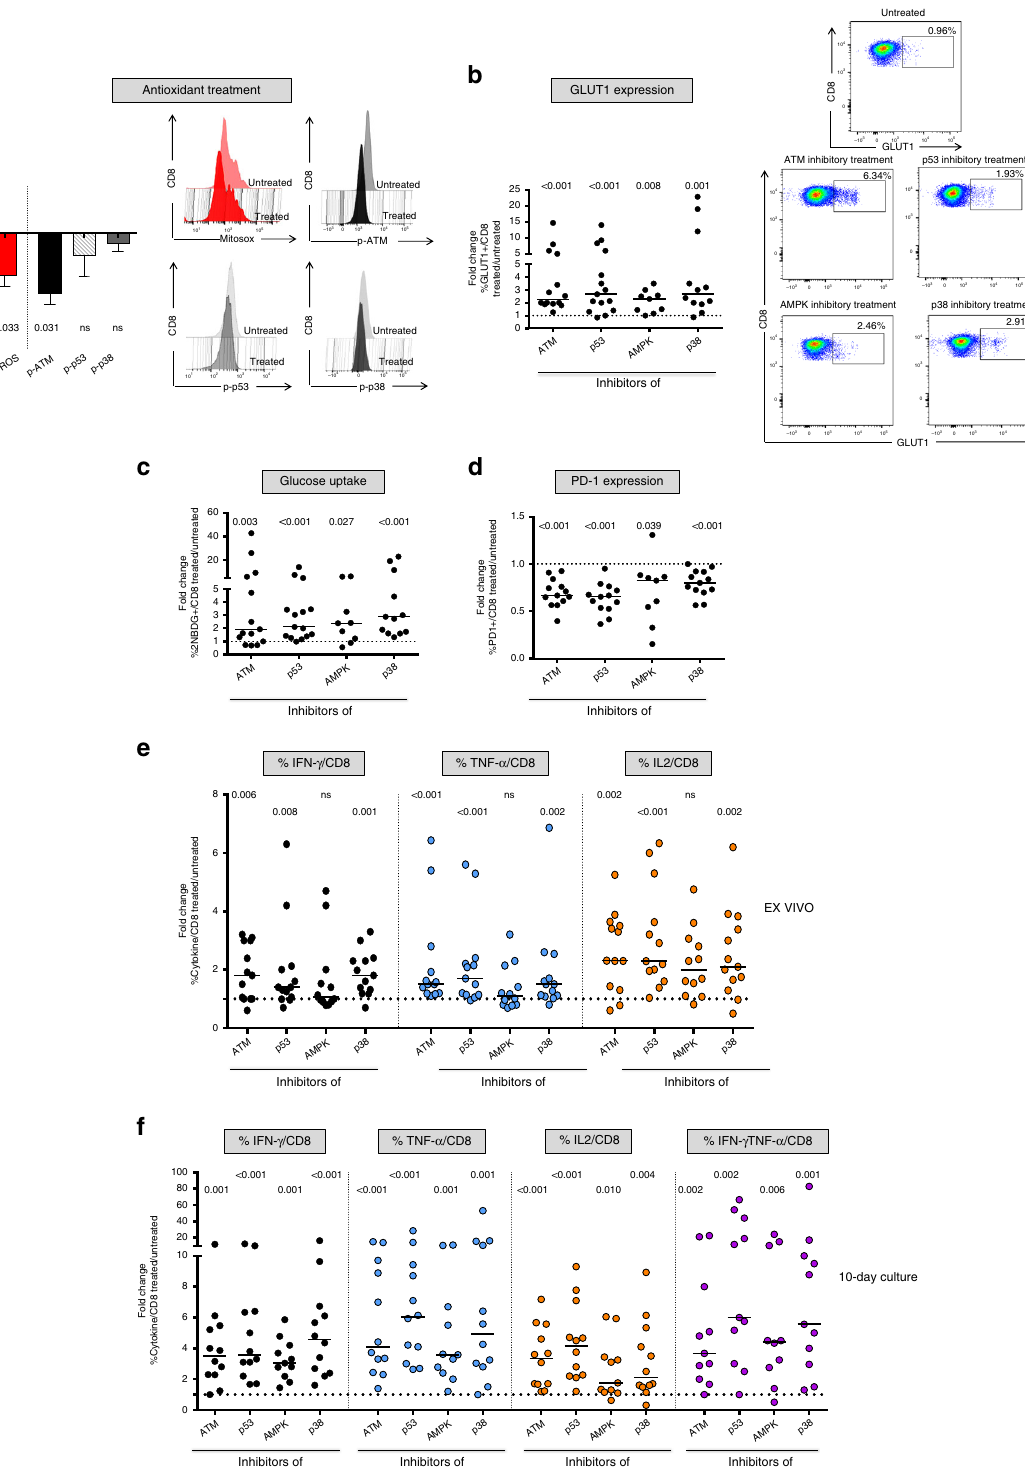
not under ex vivo conditions (Fig. 8b, c and Supplementary Fig. 11). Discussion Knowledge of the molecular and cellular features of the T cell responses associated with self-limited compared to persistent